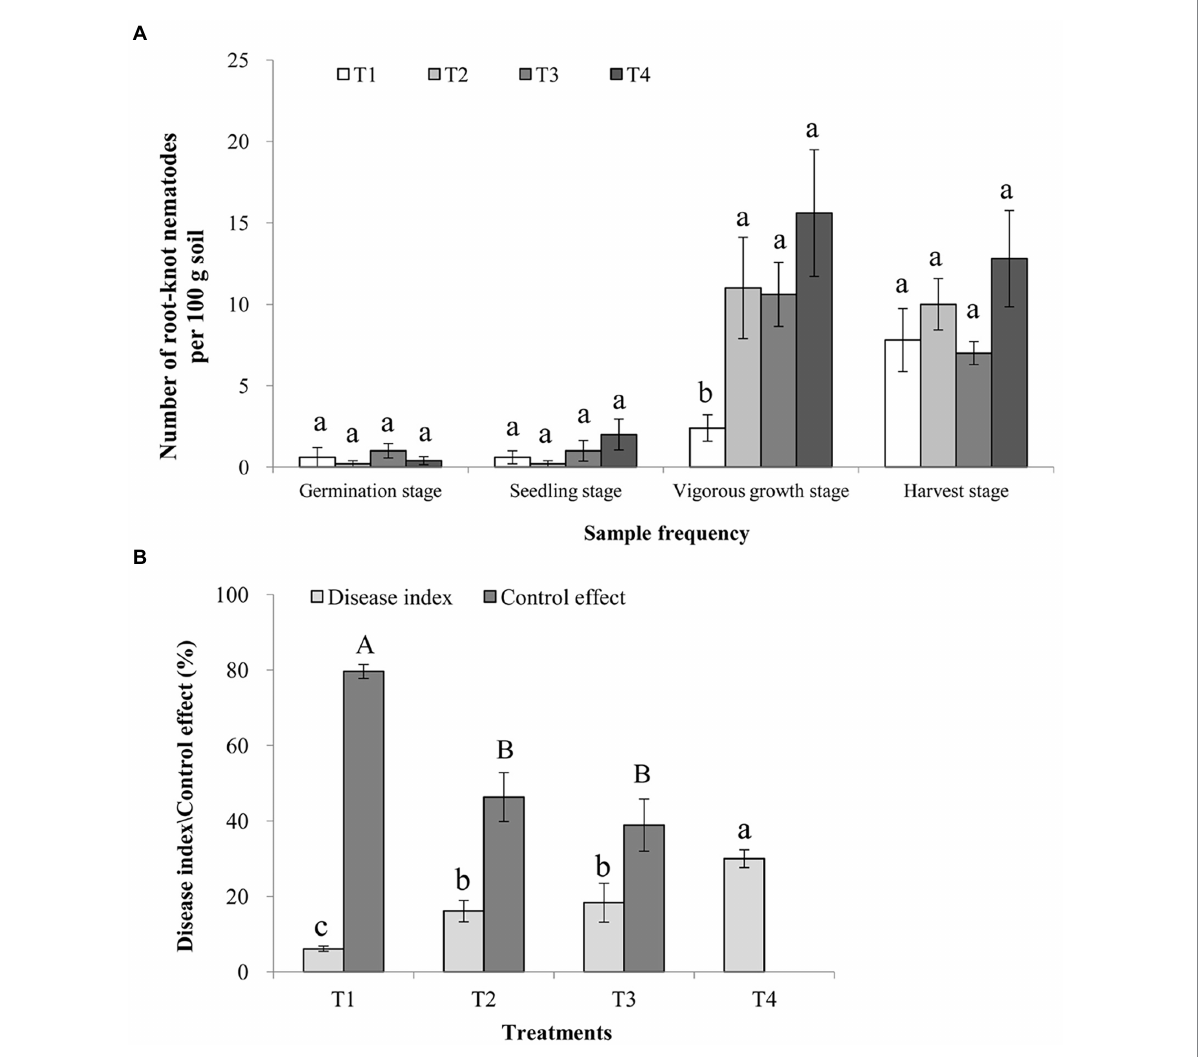
FIGURE 1 Control effects of Rhodopseudomonas palustris PSB-06 and dazomet on root-knot nematode. (A) Numbers of root-knot nematodes in various soil samples. Each soil sample was 100 g. (B) Disease indices caused by root-knot nematode and the control effects of the three treatments. T1, soil was treated with R. palustris PSB-06 and dazomet; T2, soil was treated with dazomet alone; T3, soil was treated with R. palustris PSB-06 alone; T4, soil without treatment (blank control). Same low or up case letters indicate no significant statistical difference ( p > 0.05) among the treatments, determined using the Duncan’s multiple range